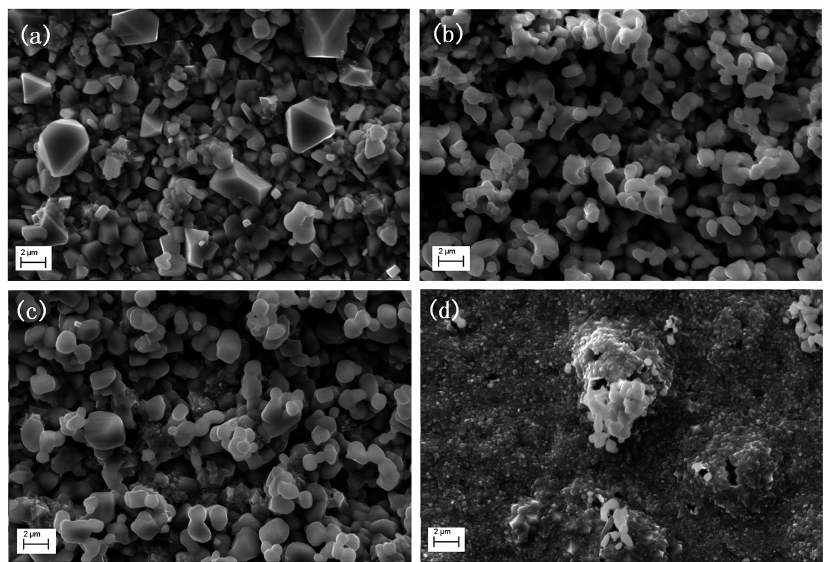
Figure 3: Surface morphology of scale 441 at 1,000°C in (a) dry air, (b) air with 3.5 vol.% H 2 O, (c) air with 8.2 vol.% H 2 O, (d) air with 11.5 vol.% H 2 O.